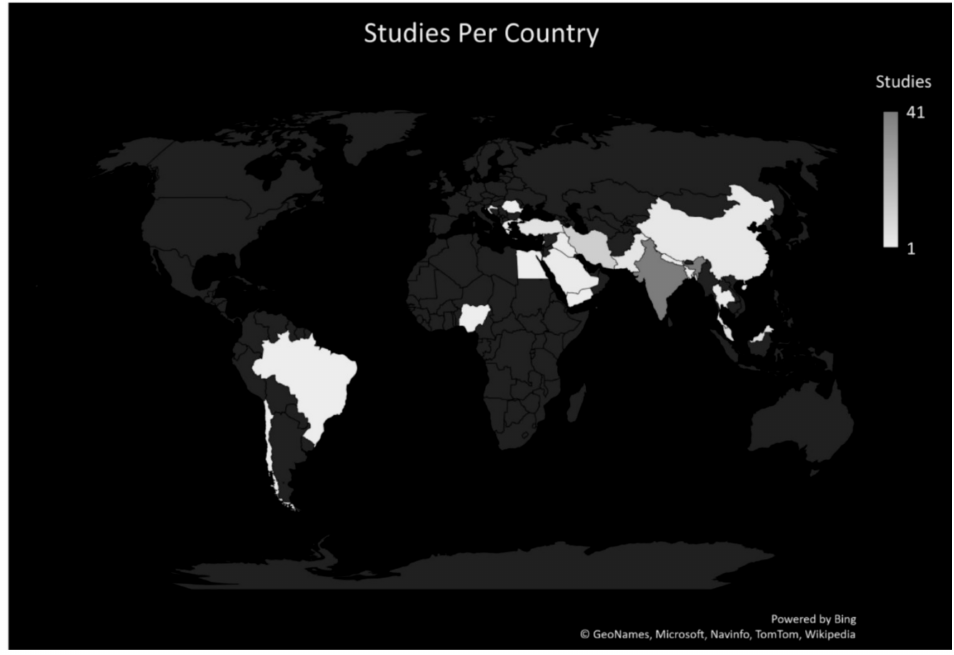
Figure 2. Geographical Location of